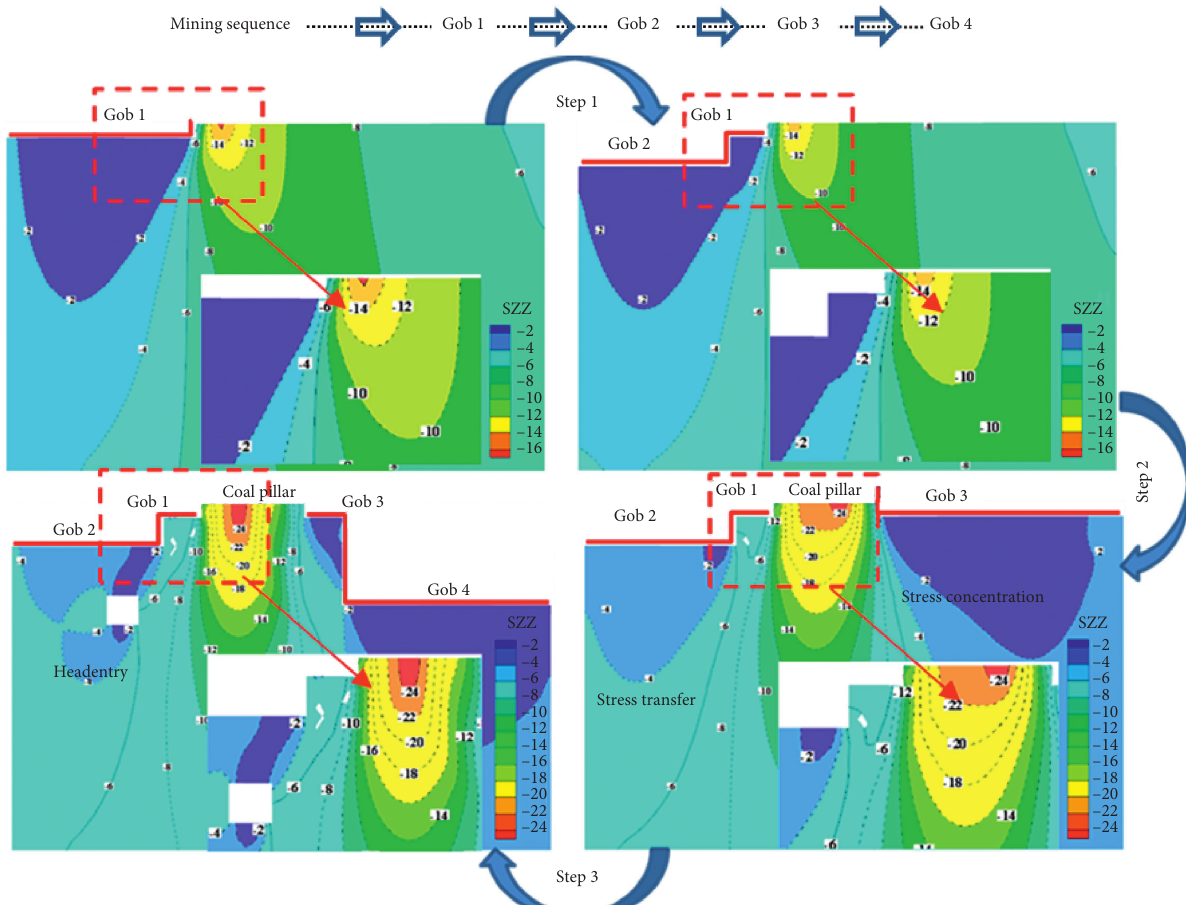
Figure 13: Stress distribution diagram of double gobs in close coal